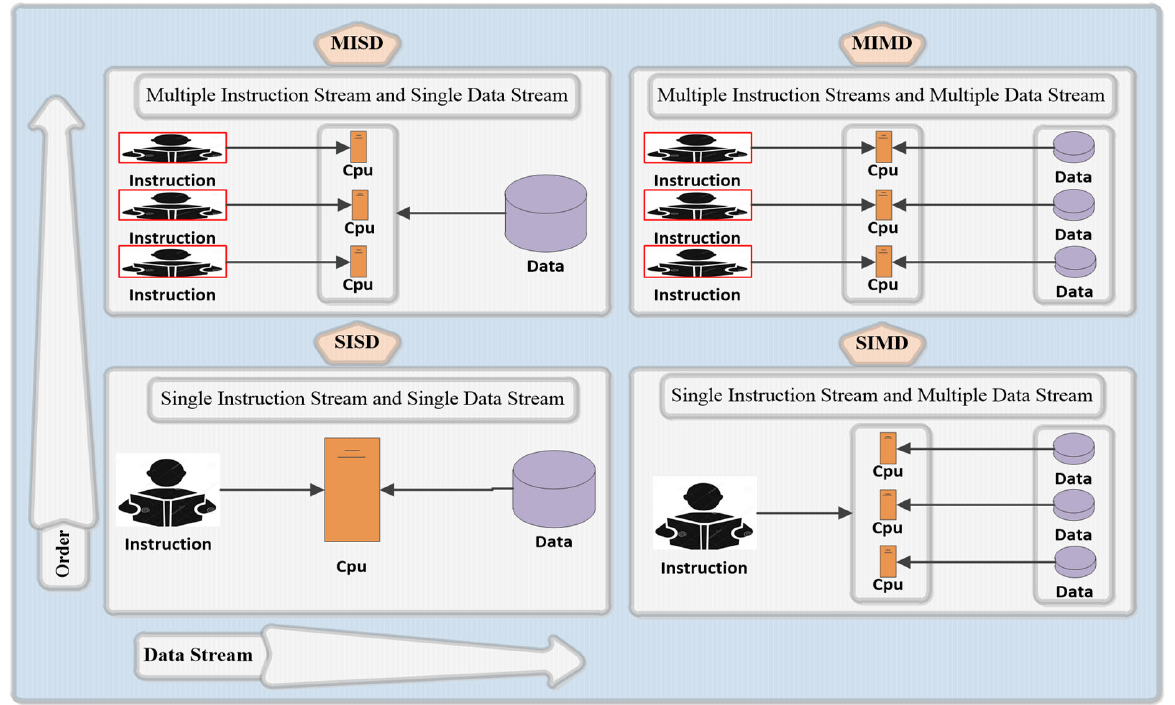
Figure 8. Classification by Flynn for computer